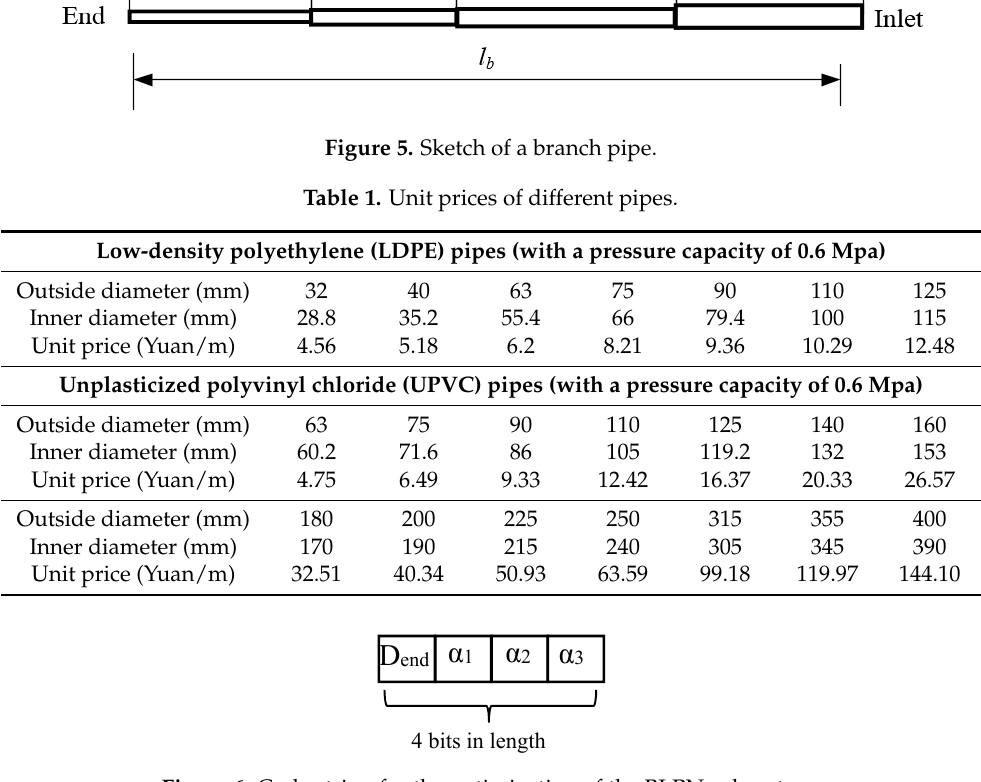
Figure 6. Code string for the optimization of the BLPN subsystem.